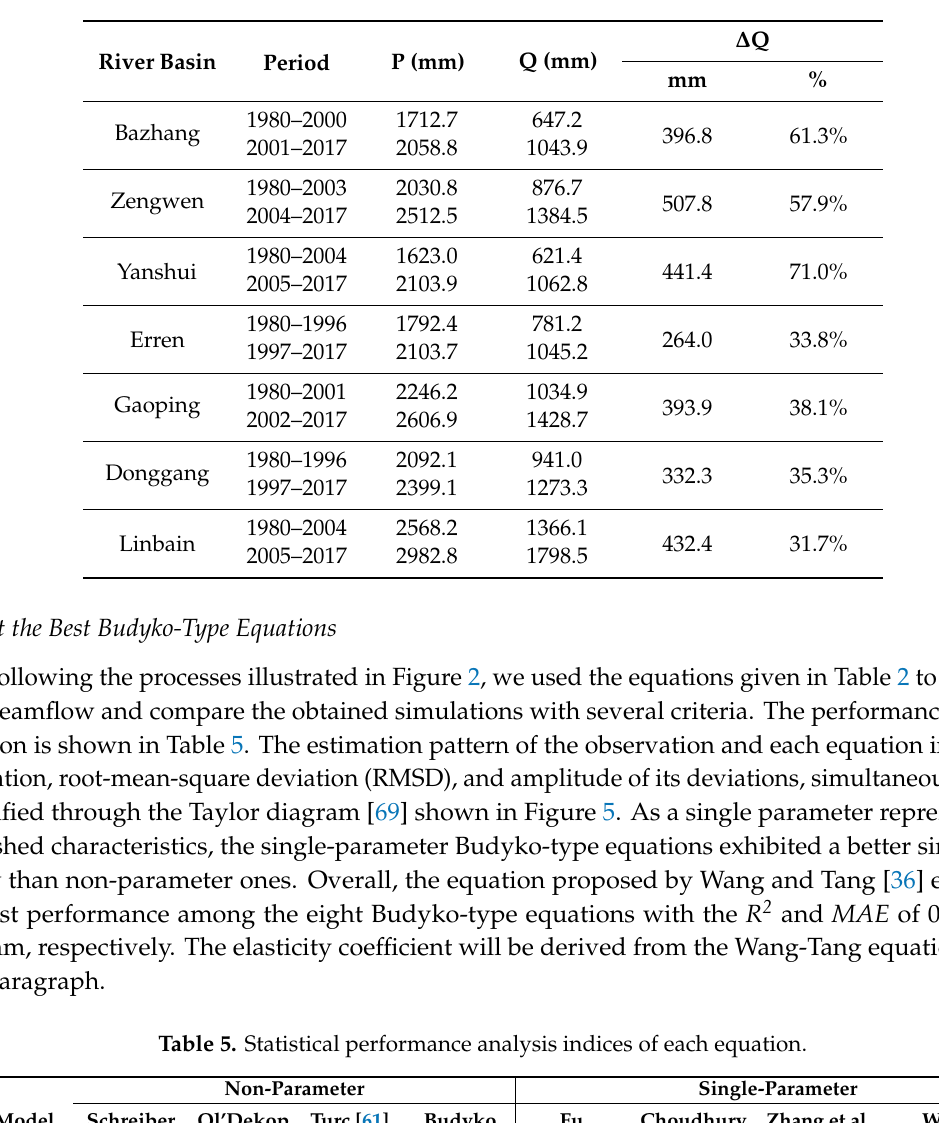
Table 4. Average annual values of streamflow and its variations from pre- and post- period in each river basin.